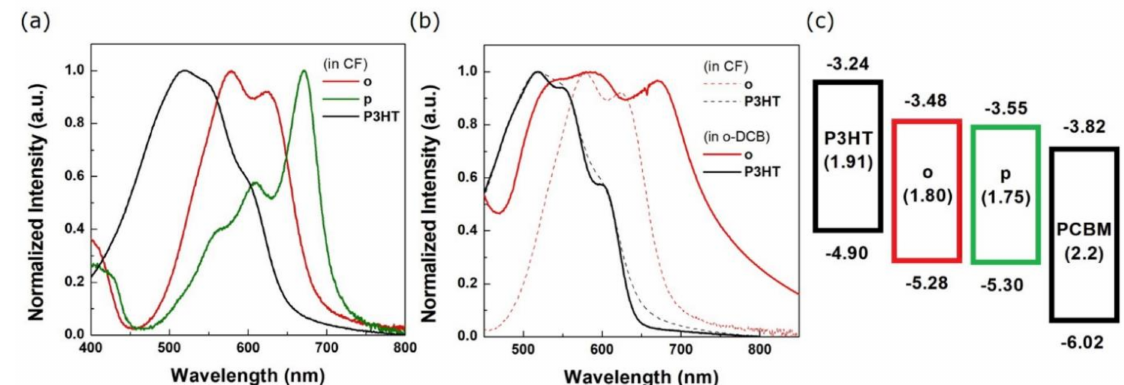
Figure 2. ( a ) Normalized UV absorption spectra of ( a ) the o -DPP-PhCN (o), p -DPP-PhCN (p), and P3HT films prepared from a chloroform (CF) solution and ( b ) the o -DPP-PhCN (o) and P3HT films prepared from CF and o - dichlorobenzene (DCB); ( c ) energy diagram of the materials used in organic solar cell (OSC) fabrication.